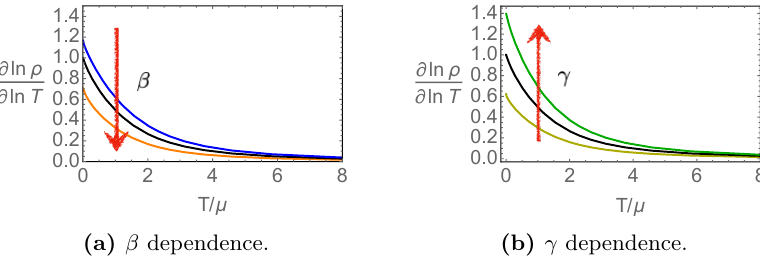
Figure 12. The exponent x in (cid:26) (cid:24) T x . The colors of the curves are chosen to be the same as the colors of the dots in (cid:12)gure